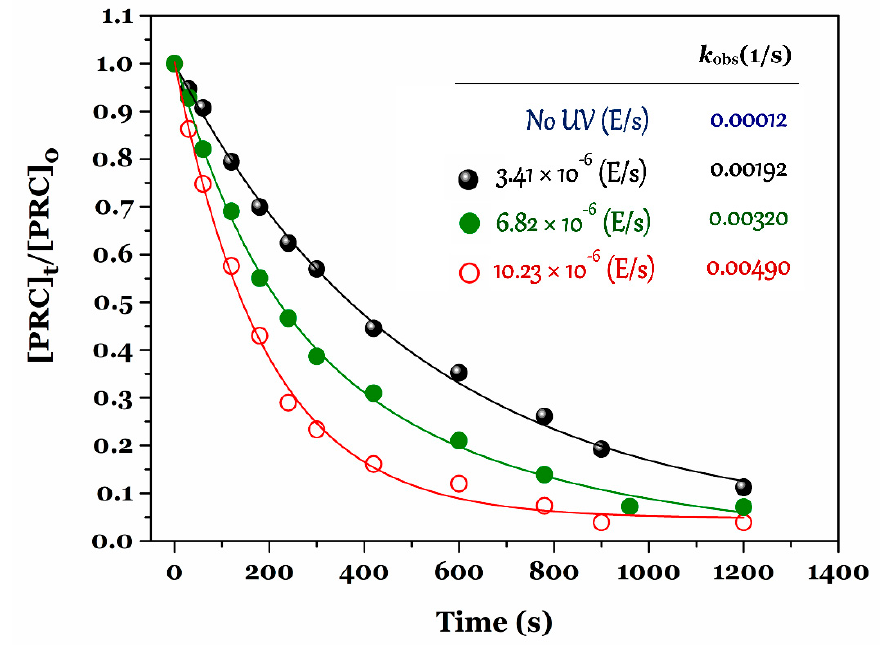
Figure 3. Effect of UV photon fluxes (Einstein/s) on the PRC degradation efficiency and rate constant by the UV/chlorine process (experimental conditions: [PRC] o ≈ 10 µ M, pH = 6.5, and [NaClO] o = 100 µ M).